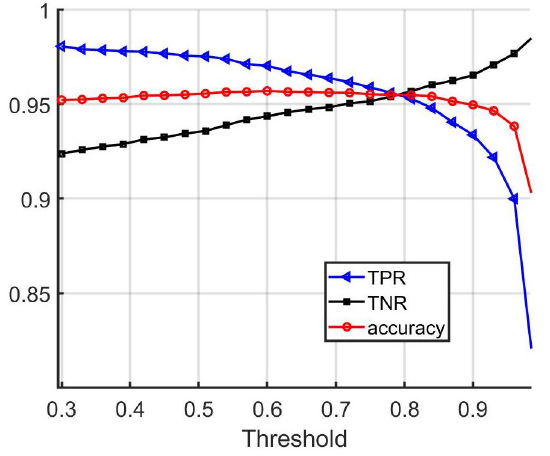
Figure 5. Performance of the vehicle matching network on the validation set with different threshold